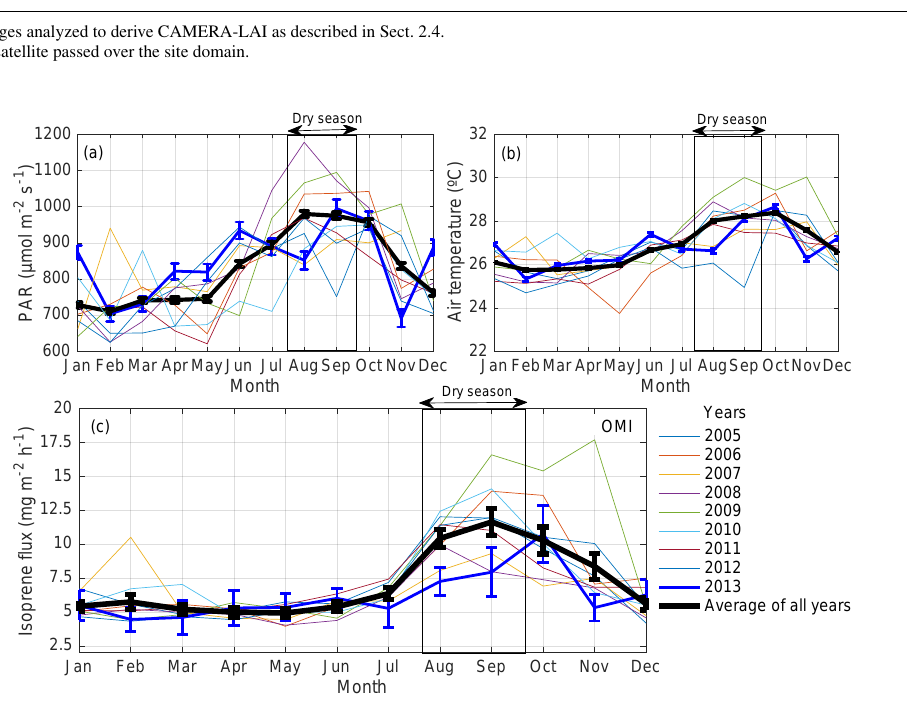
Figure 2. (a) Monthly averages of photosynthetic active radiation (PAR) and (b) air temperature from 2005 to 2013 at the K34 tower site (measured every 30min during 06:00–18:00 local time). (c) OMI satellite-derived isoprene flux at a resolution of 0.5 ◦ C centered on the K34 tower site from 2005 to 2013. Monthly averages of isoprene flux were scaled to 10:00–14:00 local time. Error bars represent 1 standard error of the